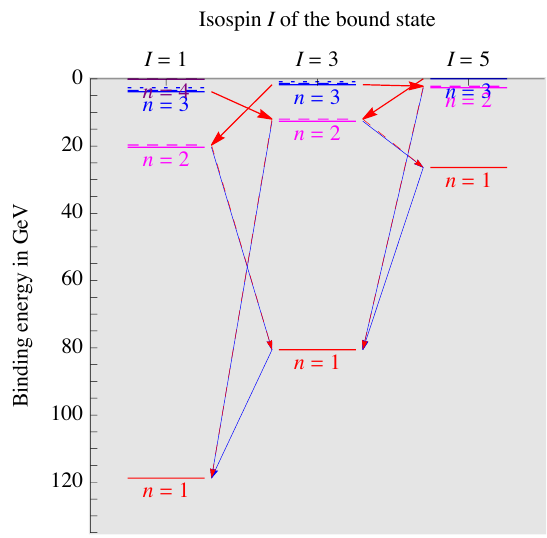
Figure 1. Energy levels of bound states of two Minimal Dark Matter 5-plets with M = 14 TeV . Continuous lines have ‘ = 0 , dashed lines have ‘ = 1 , dotted lines have ‘ = 2 . The blue (red) arrows indicate some main magnetic (electric)